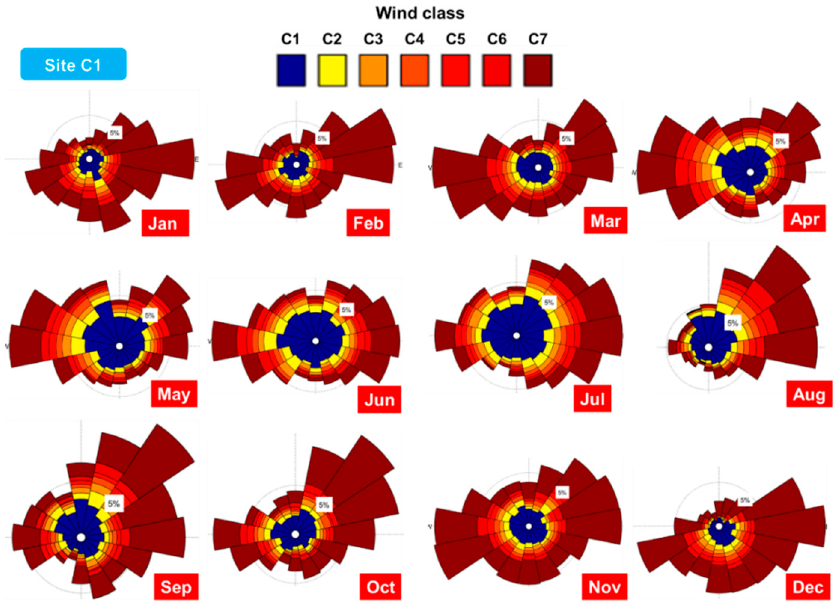
Figure 9. The monthly wind roses associated with Site C1, expressed in terms of the wind classes (C1–C7). Results reported for the 20-year time interval of 2000–2019.